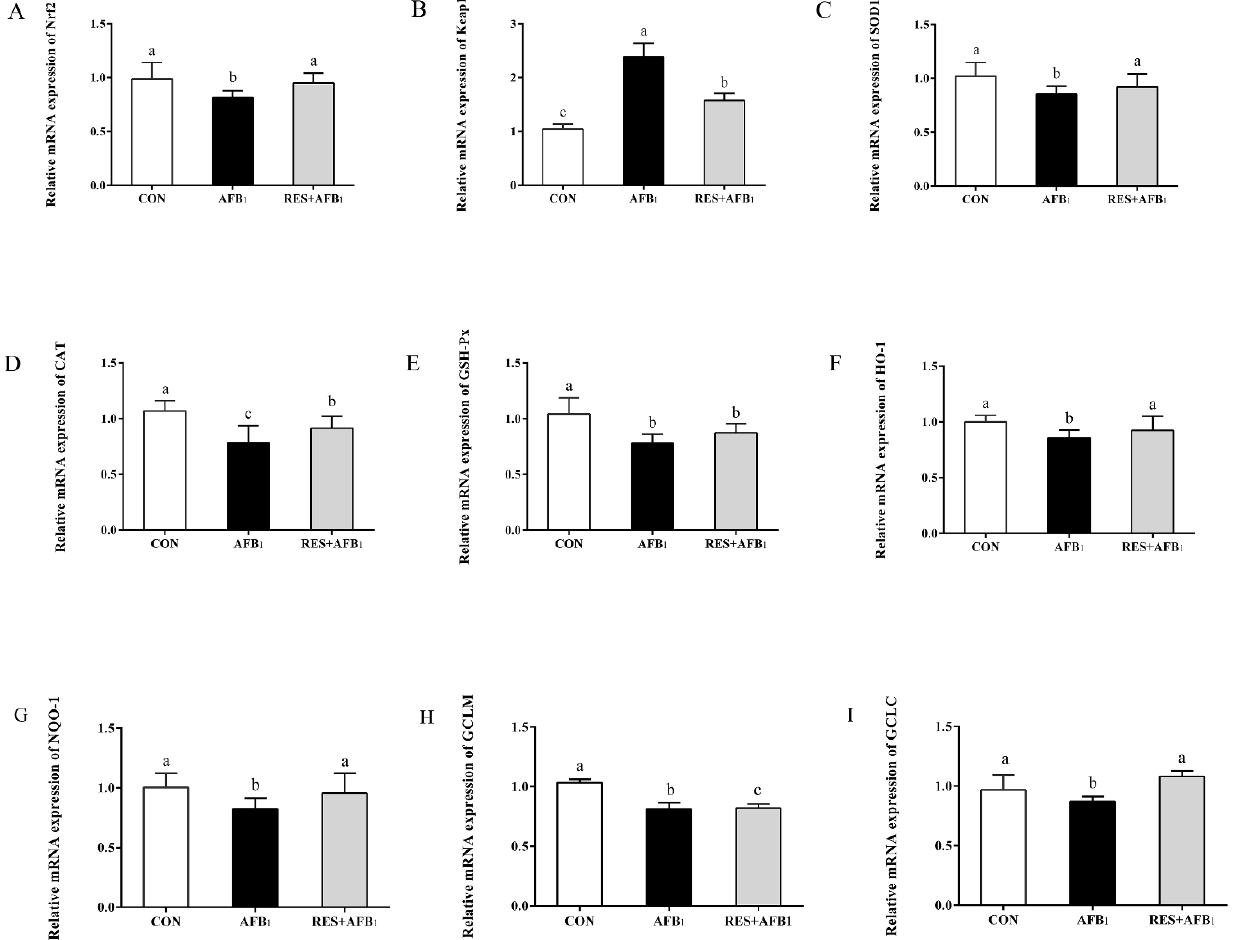
Figure 3. ( A – I ) Effect of RES on the mRNA expression levels of antioxidant genes in the ileum of AFB 1 -exposed duck. Values are expressed as mean ± SD, n = 8. Labeled (a, b, c, a > b > c) means in a row without a common letter differ, p < 0.05. Nrf2: Nuclear Factor E2-related Factor 2; Keap1: Kelch-like ECH-associated protein 1; SOD1: Superoxide dismutase 1; HO-1: Heme oxygenase-1; NQO-1: NADPH quinineoxidoreductase-1; GCLM: Glutamate-cysteine ligase modifier subunit; GCLC: Glutamate-cysteine ligase modifier